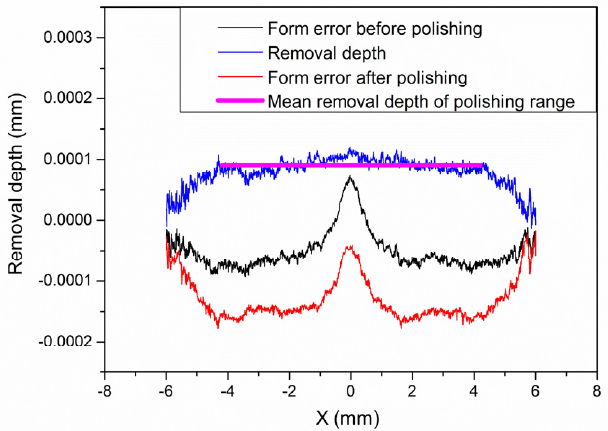
Figure 12. Profile comparison of aspherical mold for uniform polishing with small polishing disc tool.